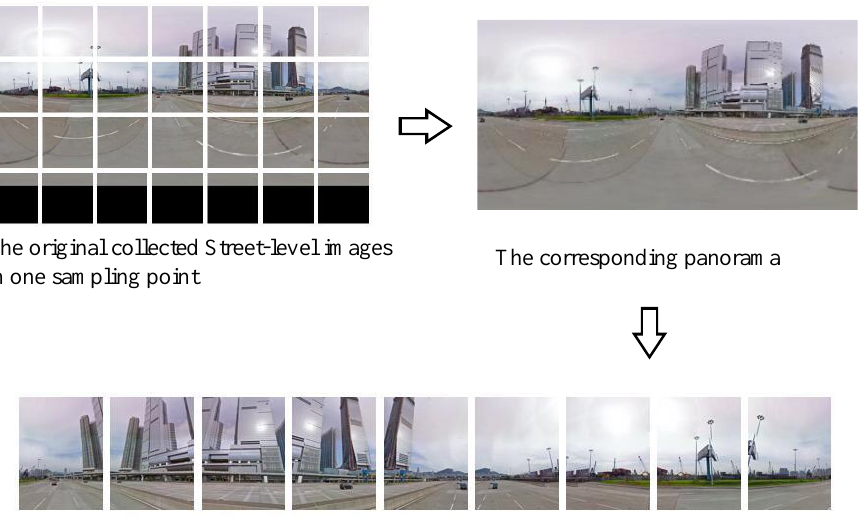
Figure 9. Graphical description of preprocess, take one sampling point as an example: firstly, grid- like images are collected for spherical projection, and then stitched it into a panorama. Street-level images of each sampling point consists of 4 rows and 7 columns. Panorama is then projected into a plan and cropped into 9